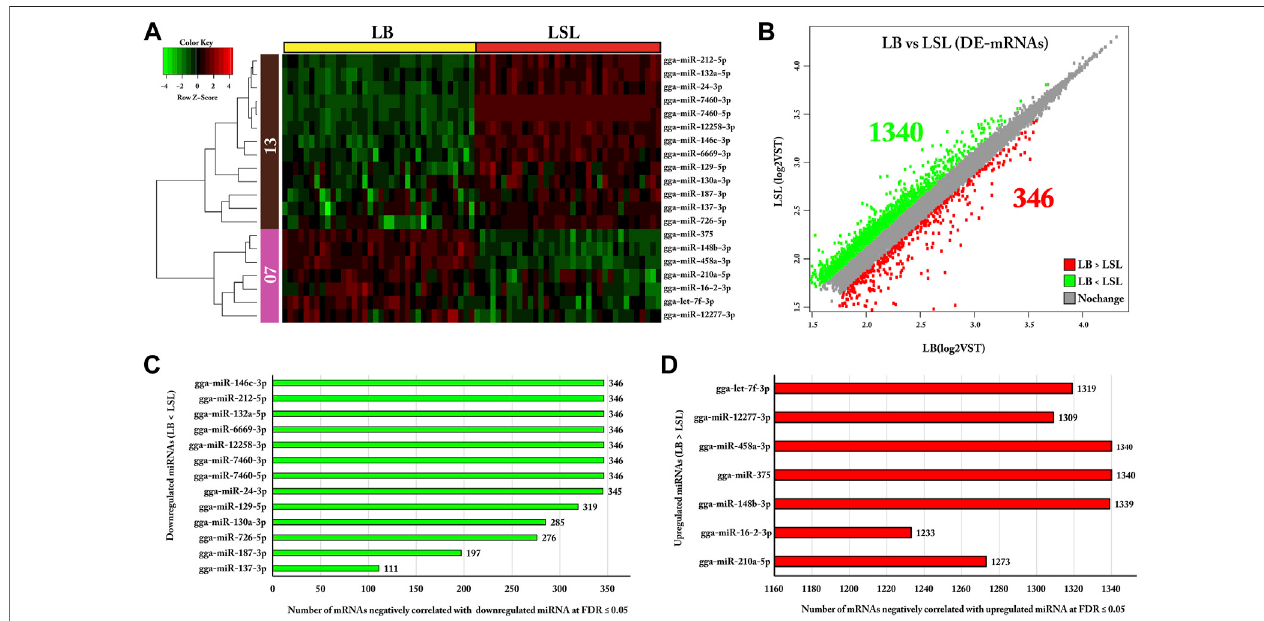
FIGURE 6 | Twenty bio-signature miRNAs, their negatively correlated DE target transcripts, and differentially expressed genes in contrast for LB vs. LSL. (A) Heatmap representing the LB and LSL expression pro fi les of 20 shortlisted miRNAs from the mixOmics. According to their co-expression, these 20 miRNAs clustered apartintwogroups,13andseven,inclustersoneandtwo,respectively.Thegreencolorrepresentsdownregulation,whiletheredindicatesupregulation. (B) Scatterplot showing differentially expressed mRNAs between LB and LSL (cutoff |VST ≥ 2, logFC ≥ 1.2|). The green and red colors indicated the downregulated and upregulated transcripts in LB, respectively, and the gray color indicated no signi fi cant difference in expression between the strains. (C) Bar chart showing the downregulatedmiRNAsinLBandupregulatedinLSLandthenumberofnegativelycorrelatedtargettranscriptsatFDR ≤ 5%. (D) Barchartrepresentingtheupregulated miRNAs in LB and downregulated in LSL and the number of negatively correlated target transcripts at FDR ≤ 5%.